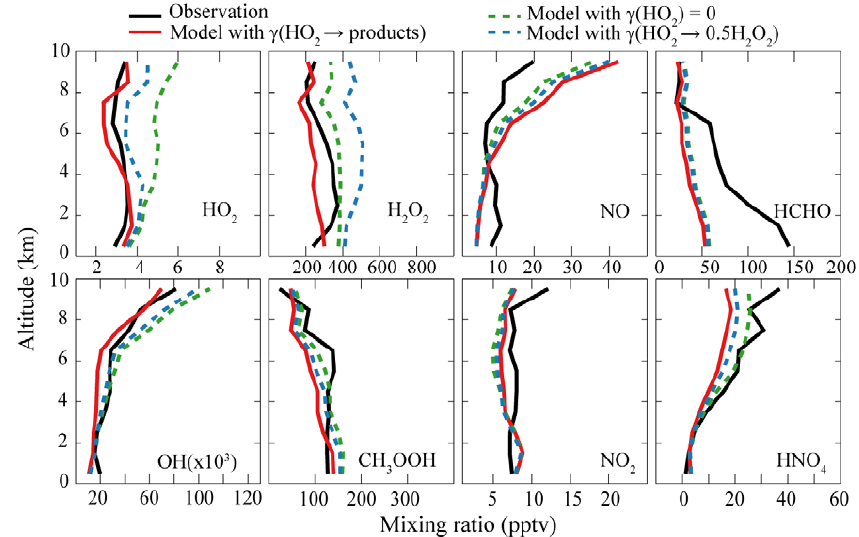
Figure 1 Median vertical profiles of HO 2 , OH, H 2 O 2 , CH 3 OOH, NO, NO 2 , HCHO, and HNO 4 concentrations during ARCTAS in the North American Arctic (1-21 April 2008). Observations from the DC-8 aircraft (black lines) are compared to three GEOS-Chem model simulations: 1) without HO 2 uptake by aerosol (green dashed line), referred to in the text as “standard GEOS-Chem”; 2) with HO 2 uptake yielding H 2 O 2 (blue dashed line); 3) with HO 2 uptake not yielding H 2 O 2 (solid red line). All concentrations are in unit of pptv except OH (ppqv). Most data were collected under sunlit conditions, between 0800 and 1800 local time. Stratospheric data were excluded as described in the text.